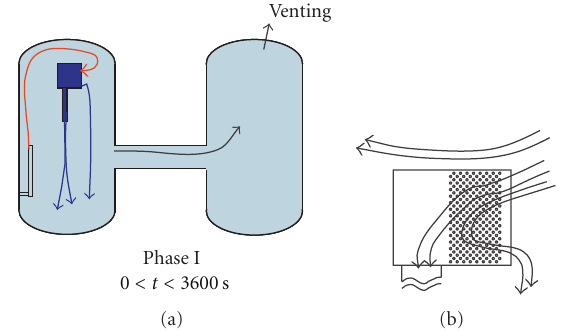
Figure 29: Suggested flow pattern for 5400 < t < 9000